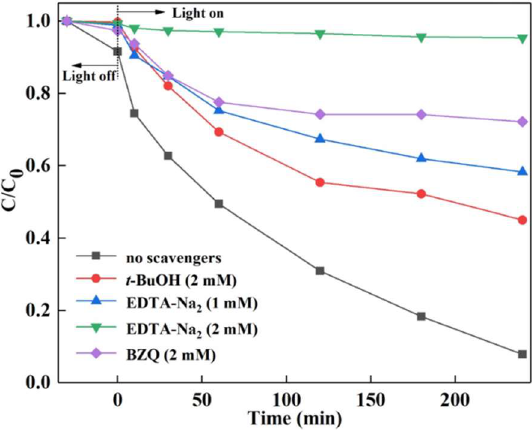
Figure 9. Photodegradation efficiency of DS under different scavengers in the system of CuBi 2 O 4 / β - Bi 2 O 3 (1:2.25, 600 °C). β -Bi 2 O 3 (1:2.25, 600 ◦